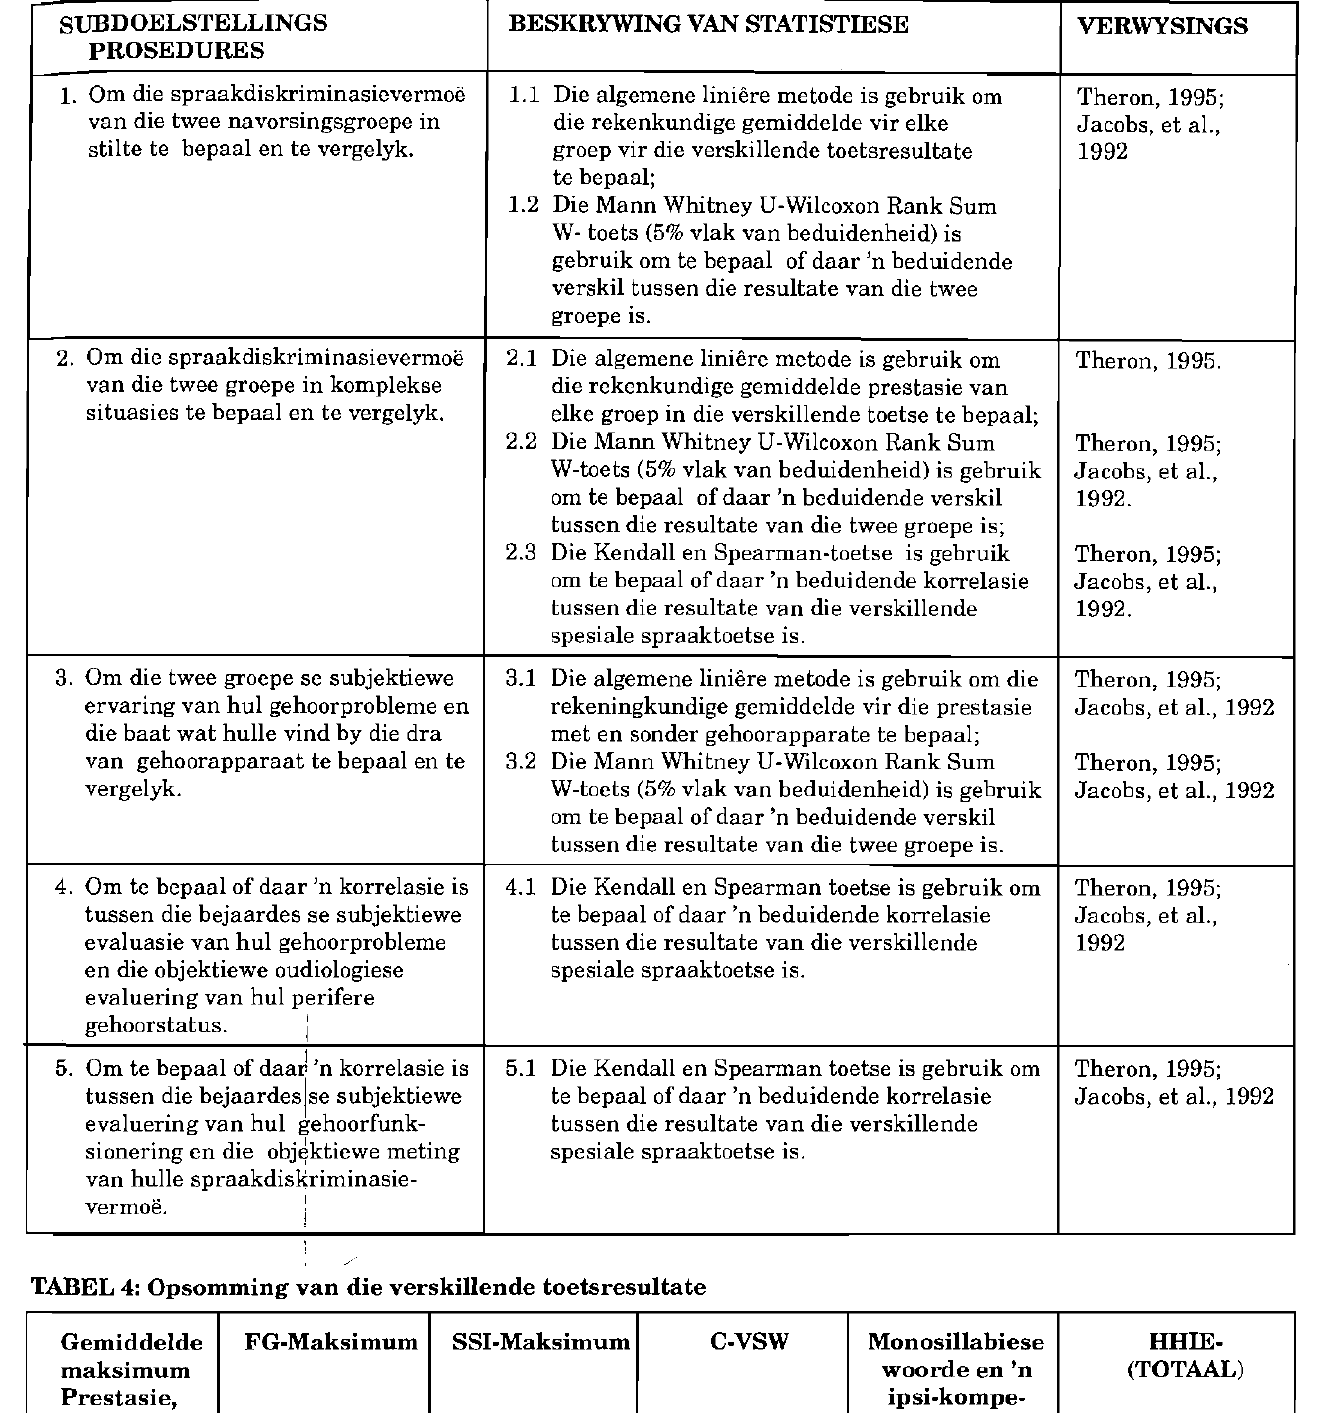
TABEL 4: Opsomming van die verskillende toetsresultate Gemiddelde maksimum